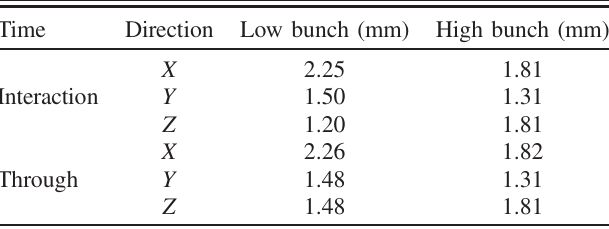
TABLE I. Average rms beam sizes during interaction and through the accelerating cavity.